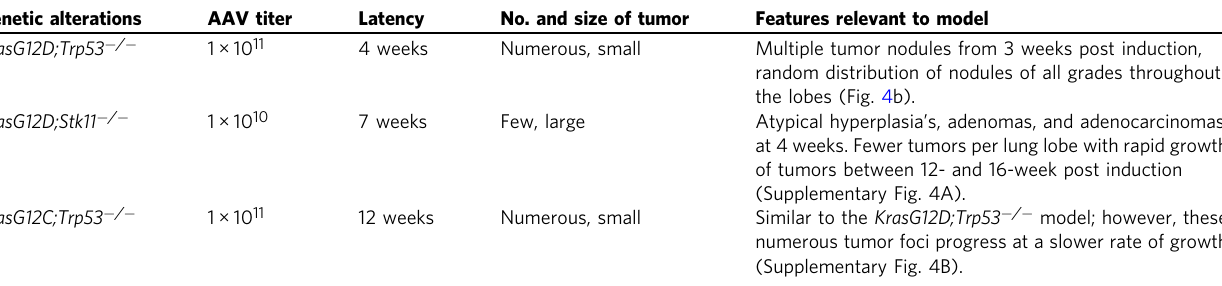
Table 2 Non-small cell lung cancer (NSCLC) models developed by AAV9 transduction in the ODInCas9 mouse. Genetic